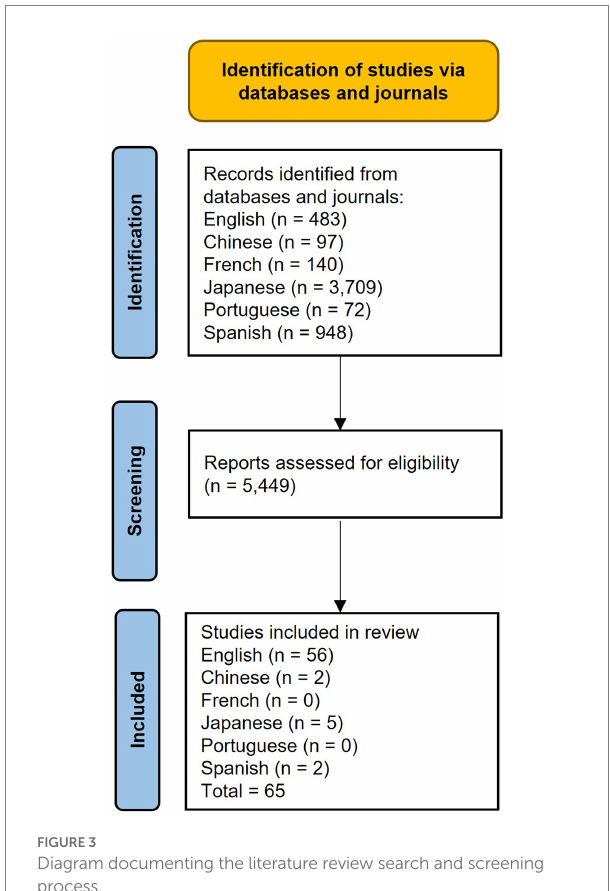
FIGURE 3 Diagram documenting the literature review search and screening